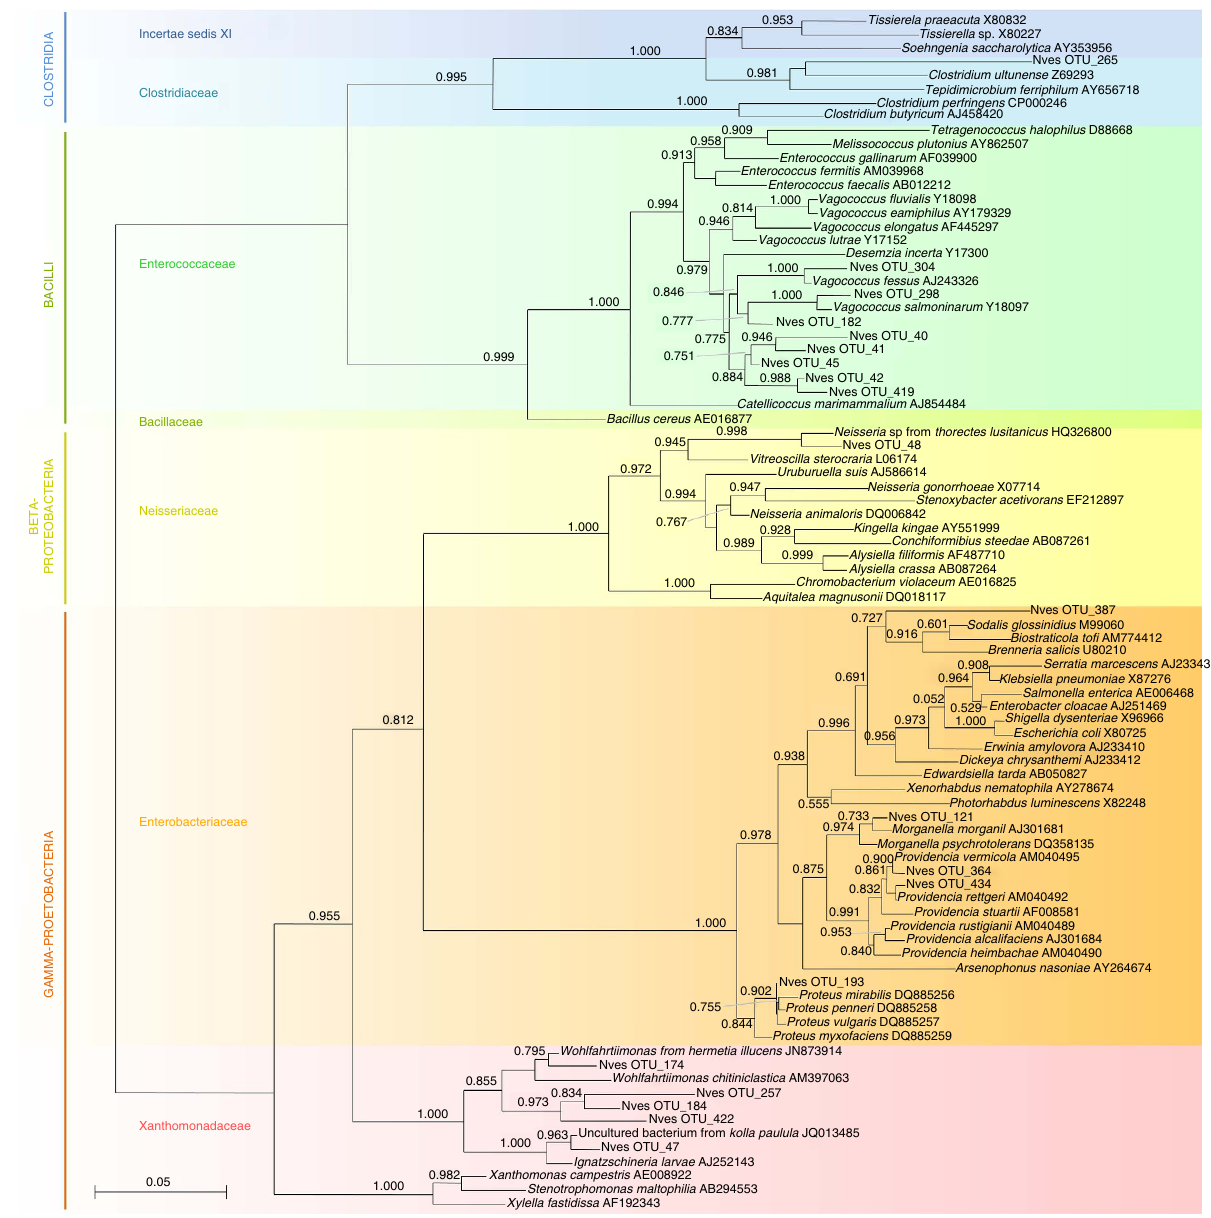
Figure 4 | Phylogenetic affiliation of the 20 most abundant bacterial OTUs in adult and larval N. vespilloides . Based on partial 16 S rRNA gene sequences (TEFAP). Sequences were aligned in SINA and ARB, and the phylogeny was reconstructed using